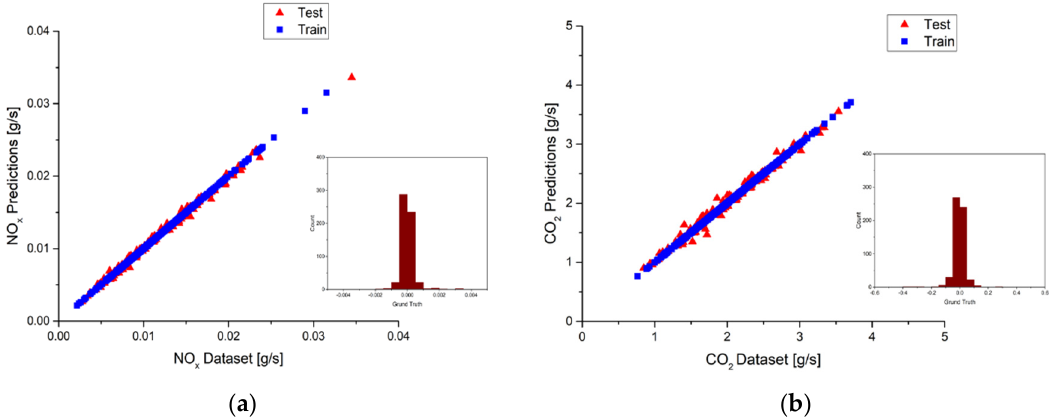
Figure 20. ( a ) Deviations between the predictions and the measurements and ground truth plot of the best NO x model in